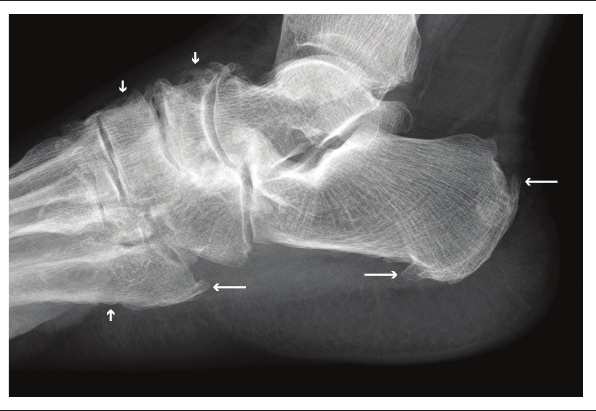
FIGURE 6: Magnified view of the proximal metatarsals and tarsal bones of the right foot clearly demonstrating periostitis (short arrows) and enthesitis (long